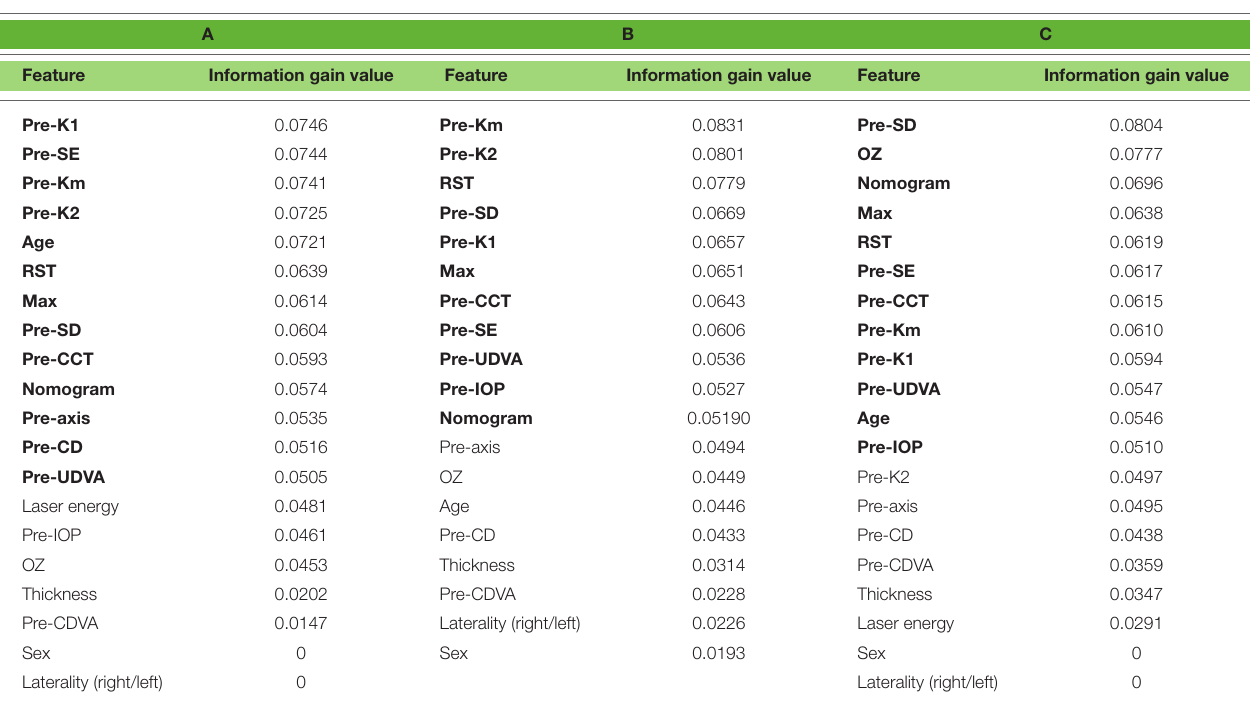
TABLE 2 | Features affecting postoperative